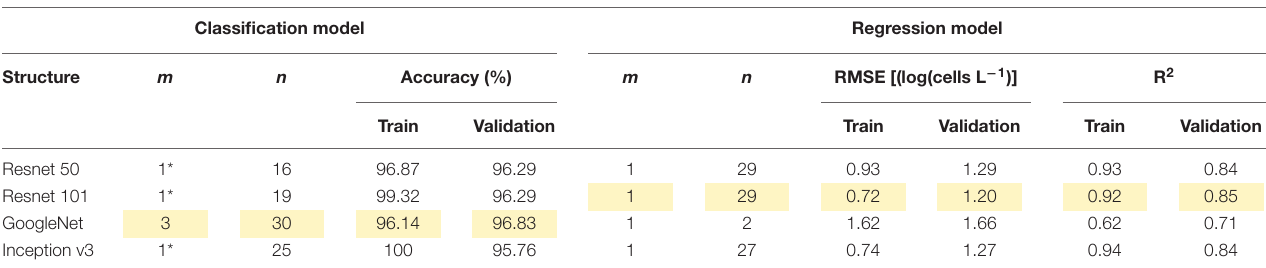
TABLE 1 | Model performance and optimal inputs ( m and n